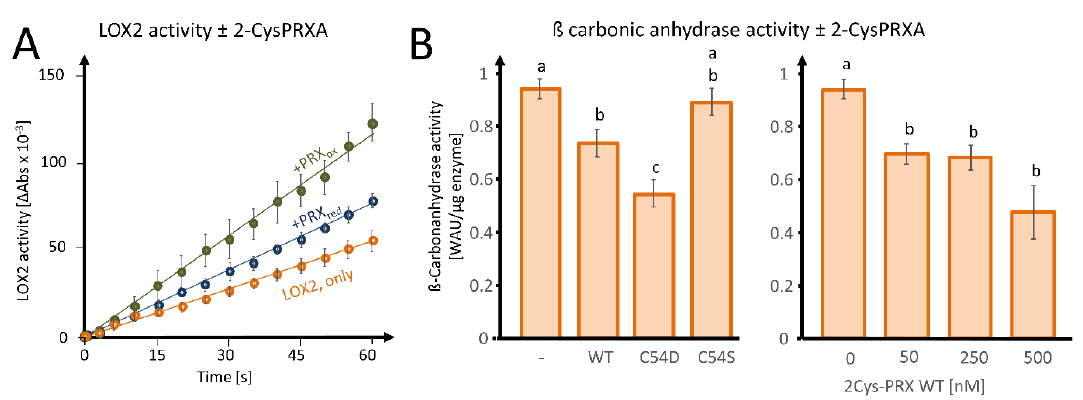
Figure 6. E ff ects of 2-CysPRX on LIPOXYGENASE 2 (LOX2) and ß-CARBONIC ANHYDRASE activities. ( A ) E ff ect of reduced or oxidized 2-CysPRX (0.5 µ M monomer concentration) on LOX2 activity (0.5 µ M recombinant protein). Reduced 2-CysPRXA improves α -linolenic acid oxidation activity slightly compared with non-treated LOX2 alone (green). Oxidized 2-CysPRXA doubled the oxidation rate of α -linolenic acid. ( B ) E ff ect of WT, C54S, and C54D protein of 2-CysPRX (250 nM) on ßCA1 (50 nM) activity monitored spectrophotometrically using the pH indicator phenolred. Experiments were conducted with two independently generated recombinant protein lots and represent means ± SE of n ≥ 10 (variants) and n ≥ 8 (concentration-dependency). Data were analyzed for statistical significance of di ff erence using one way analysis of variance (ANOVA) and post-hoc Tukey HSD (honestly significant difference).